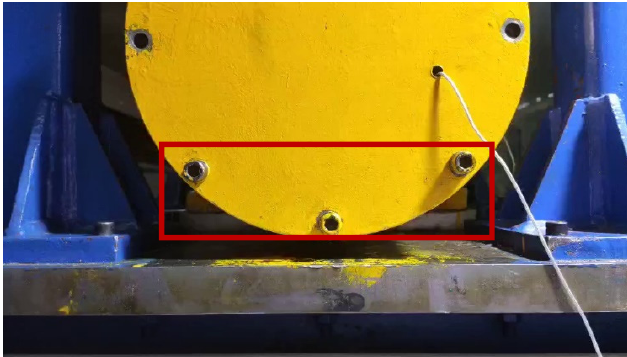
Figure 6. Displacement video capture scheme.